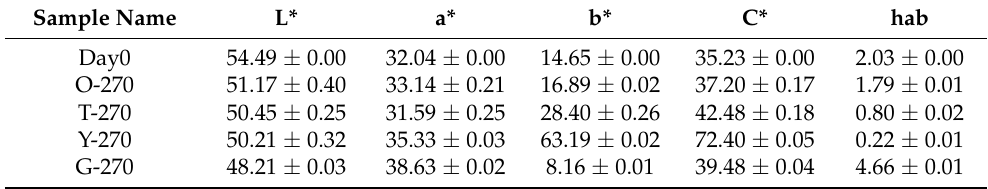
Table 3. CIELAB color parameters of red wine samples in different aging